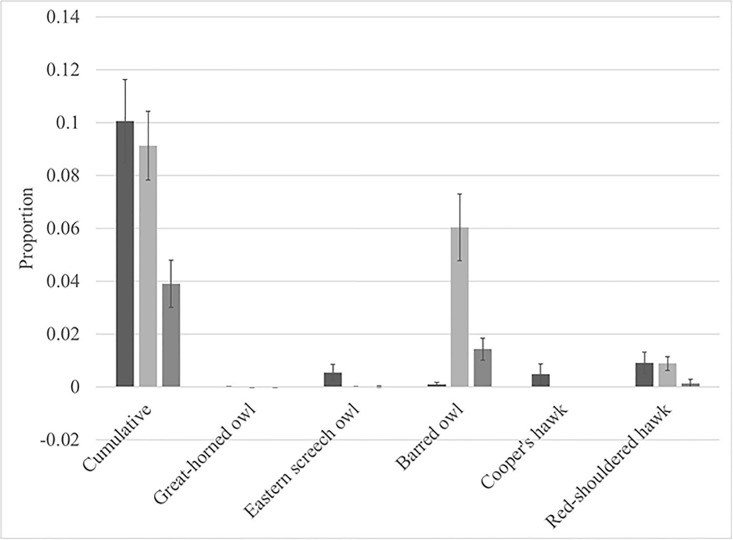
Proportion (Mean ± SE) of samples that contained at least one raptor call. Sample represents a 30 minute acoustic recording. Data for individual owl species are least means squares (see text); means/standard error otherwise derived from raw data.Undisturbed site data is represented by the left bar (dark grey), mid-disturbed site data is represented by the middle bar (light grey), and most-disturbed site data are represented by the right bar (second lightest shade of grey).